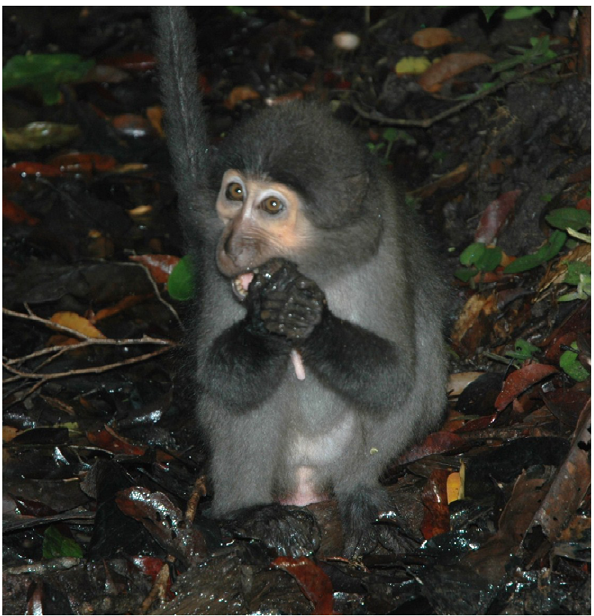
Figure 3. Sooty mangabey female processing Sacoglottis gabonensis in the Taı¨ Forest, Coˆte d’Ivoire. Isometric biting with the postcanine teeth is an ingestive behavior associated almost exclusively (93.4% of all events) with Sacoglottis .